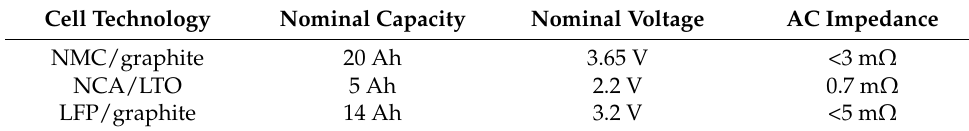
Table 1. Battery cells specifications.